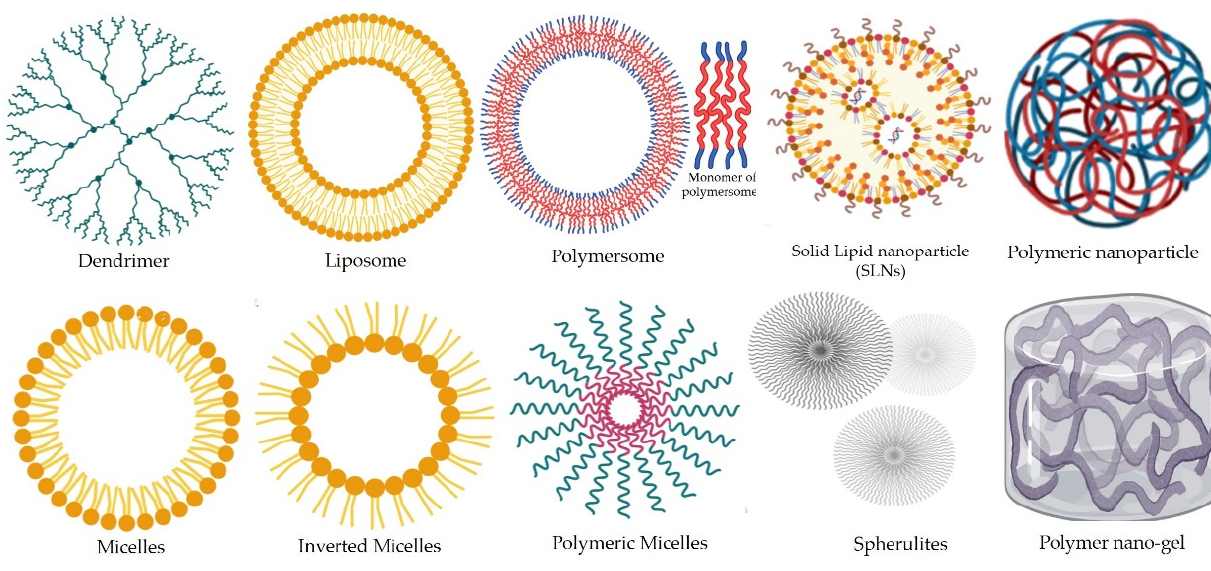
Figure 1. Nanovehicles for effective and smart delivery of therapeutic drugs and other anti-fungal agents.